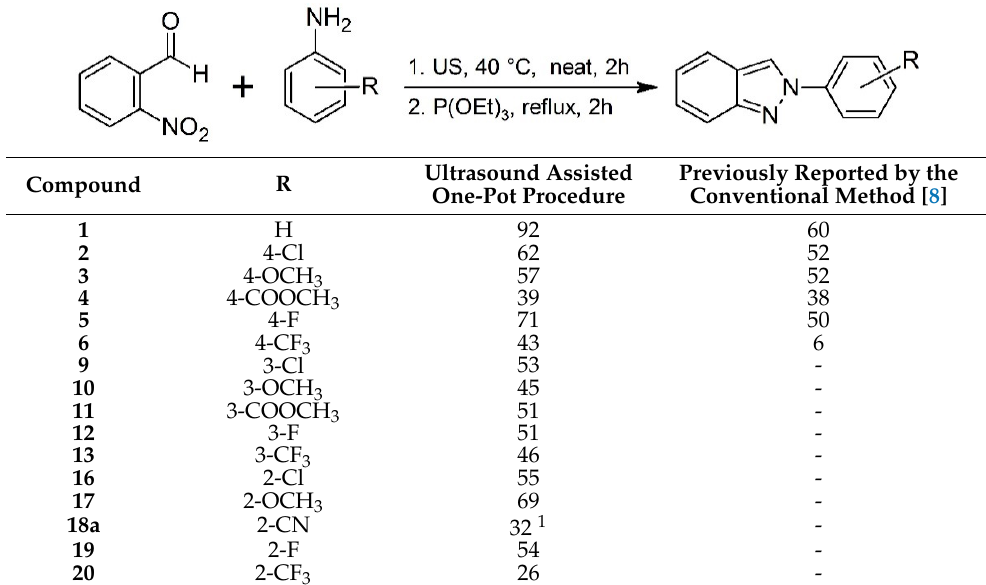
Table 1 . Chemical yield (%) for 2-phenyl-2 H -indazole derivatives synthesized by ultrasound assisted one-pot procedure, and representative examples of these same compounds synthesized by the conventional method.